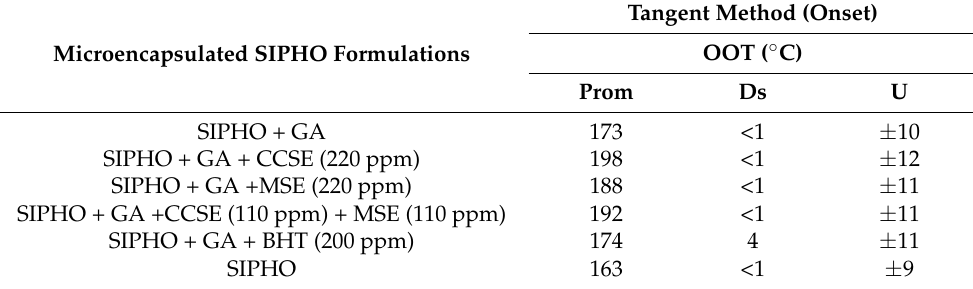
Table 7. Oxidation onset temperature (OOT) ( ◦ C) of sacha inchi ( P. huayllabambana ) oil (SIPHO) microencapsulated.